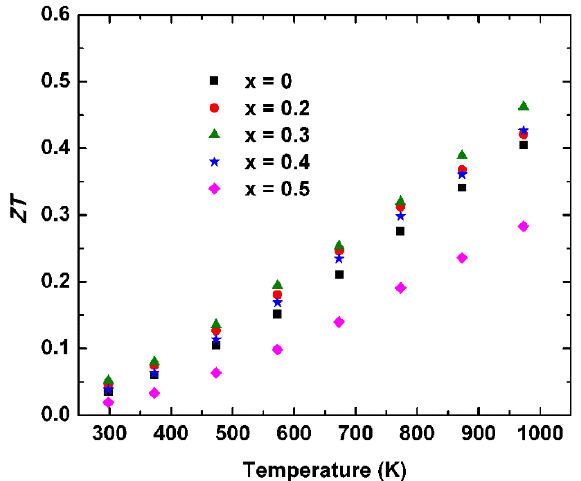
Figure 5. Temperature dependent ZT values of half-Heusler compounds NbCo 1+ x Sb ( x = 0, 0.2, 0.3, 0.4, 0.5).